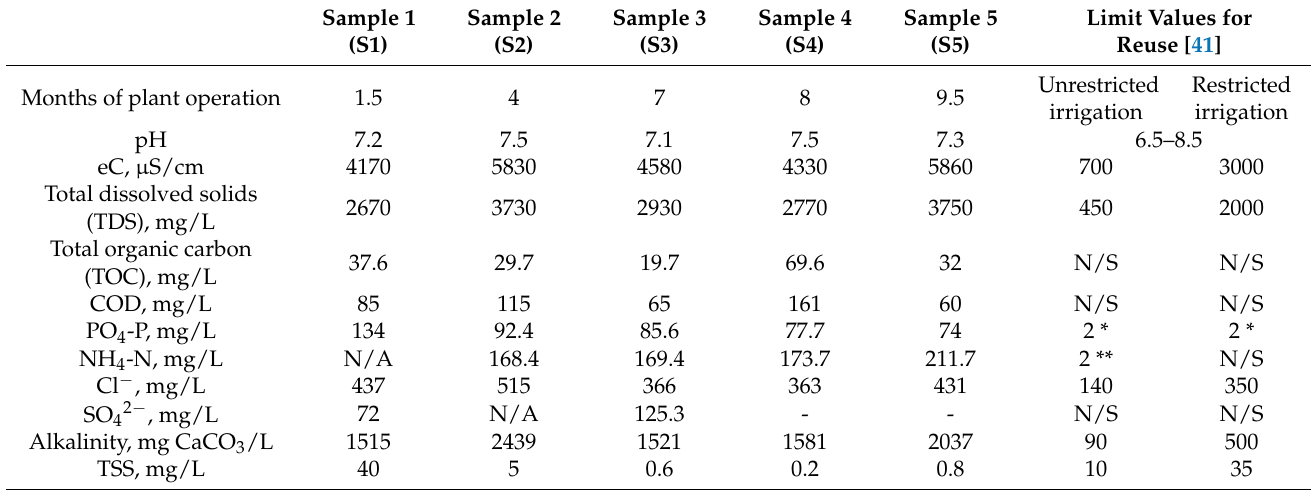
Table A1. Physicochemical characteristics of the real Filtered Liquid Digestate (FLD) samples, used as feed solution in this